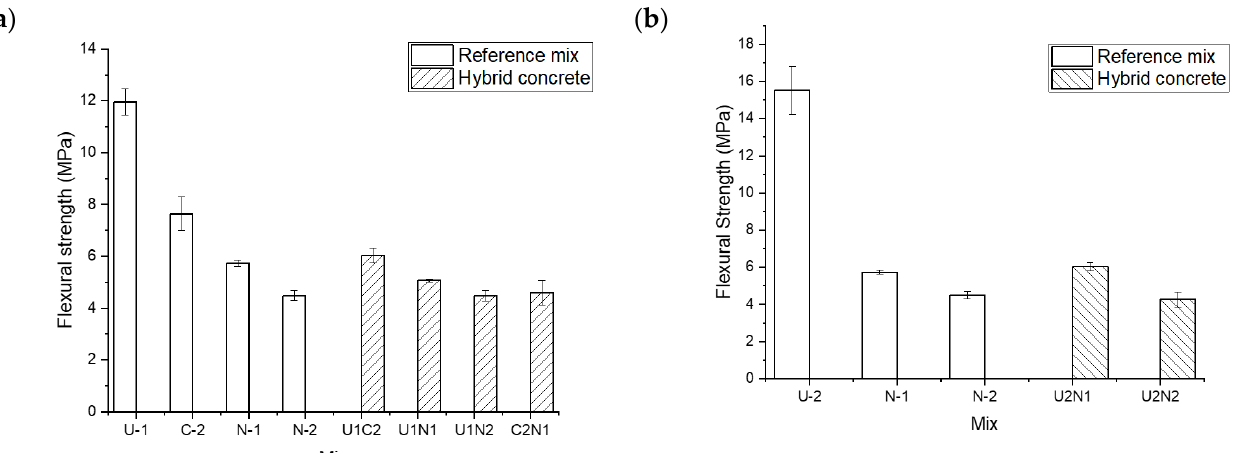
Figure 11 . Flexural strengths of hybrid concrete casted in the vertical arrangement; ( a ) combination with UHPC (U1), ( b ) combination with UHPC containing steel fibers (U2) .